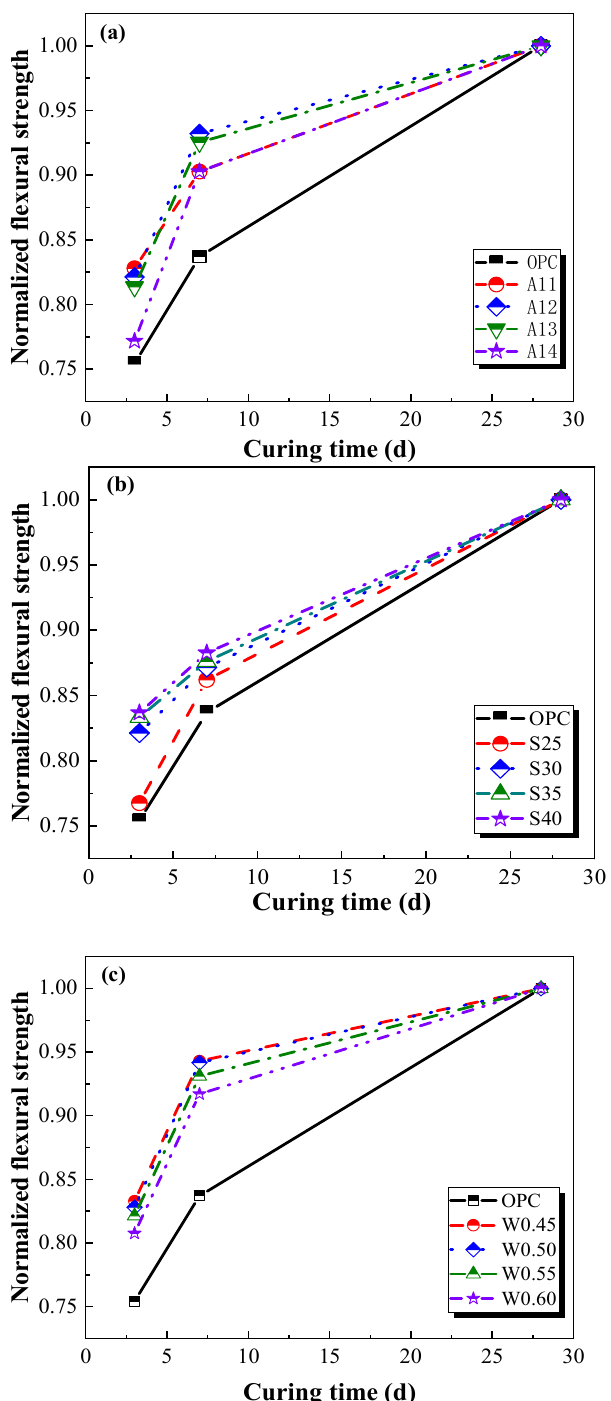
Figure 2. Normalized flexural strength of various specimens: ( a ) alkali content; ( b ) slag content; ( c ) water-to-binder ratio.